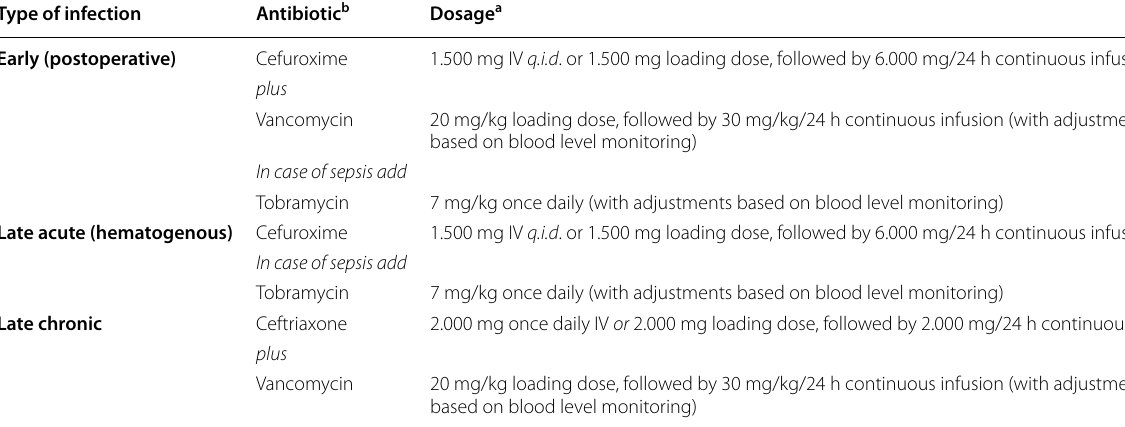
a The above doses are based on adequate kidney function and a normal weight/BMI. In case of deviating values, contact the hospital pharmacist for dosing advice b In the case of revision surgery also administer antibiotic prophylaxis in accordance to protocol; BMI surgical